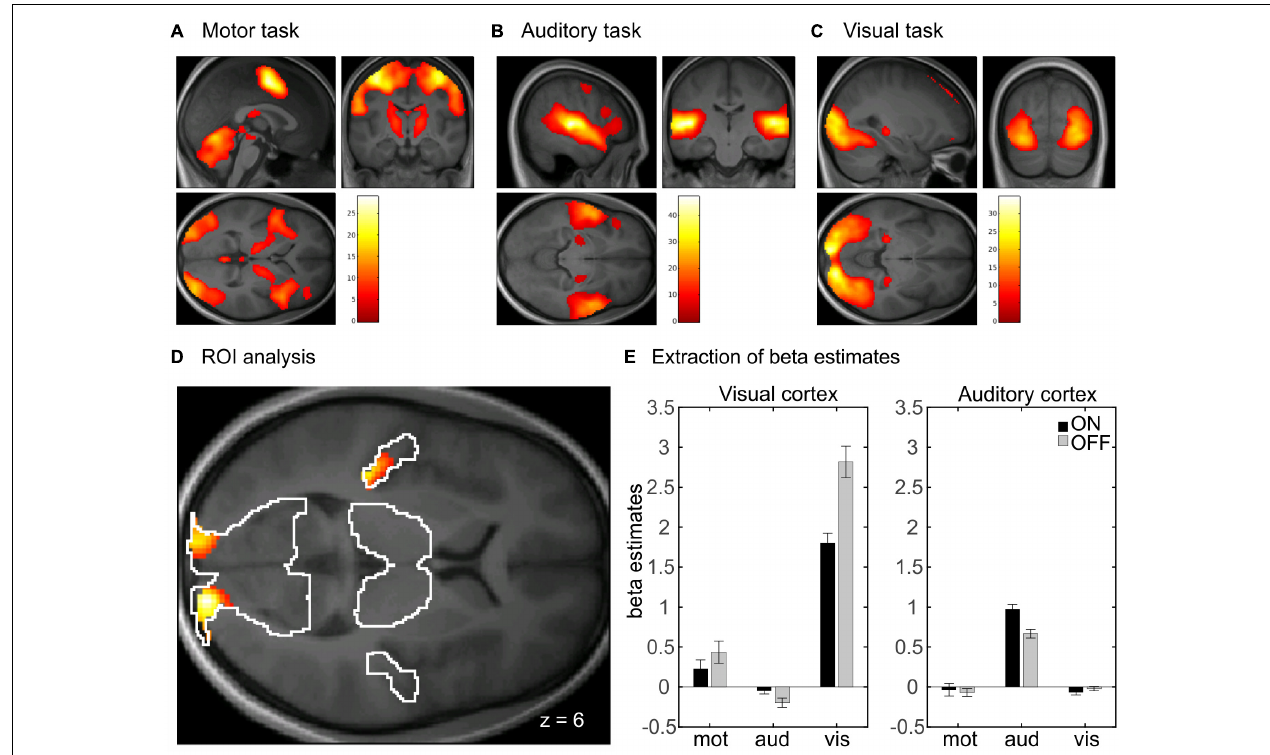
FIGURE 4 | Whole-brain analyses with main effect of task separated for (A) motor, (B) auditory, and (C) visual tasks. Results are whole-brain FWE corrected ( p < 0.05) with cluster level > 100. (D) Interaction between task and prescan normalize in whole-brain fMRI analysis. ROI analyses with activation in bilateral visual cortex and left auditory cortex, FWE corrected ( p < 0.05). (E) Extraction of β estimates in peak maximum of the visual and auditory cortex. β estimates for prescan normalize OFF (gray) are larger in the visual cortex for both tasks involving visual cortex activity, i.e., the visual and the motor task. β estimates in the auditory cortex are larger for prescan normalize ON (black). FWE, family wise error; ROI, region of interest.